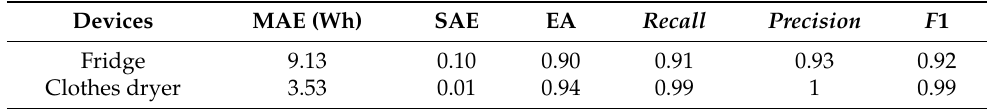
Table 18. Results on AMPD public